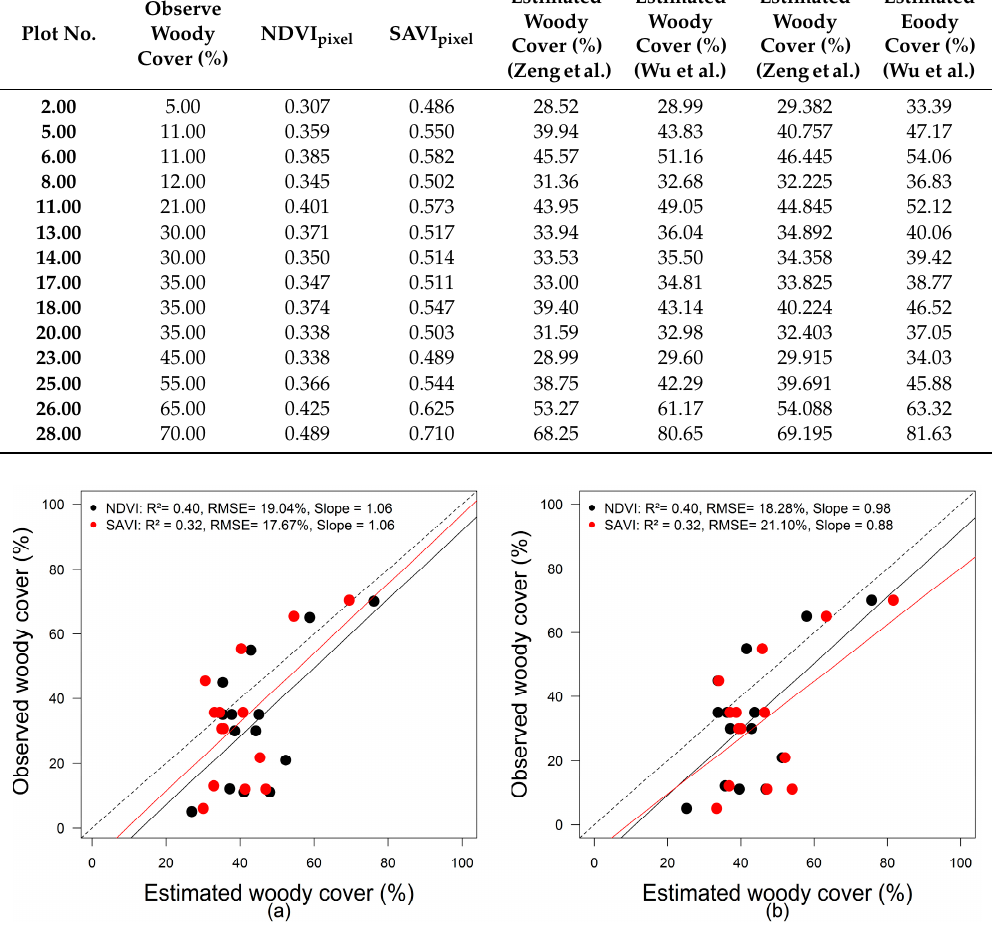
Figure 8. Validation of NDVI and SAVI woody cover estimates from the ( a ) modified procedure by Zeng et al. [34] and the ( b ) modified procedure by Wu et al. [35] .